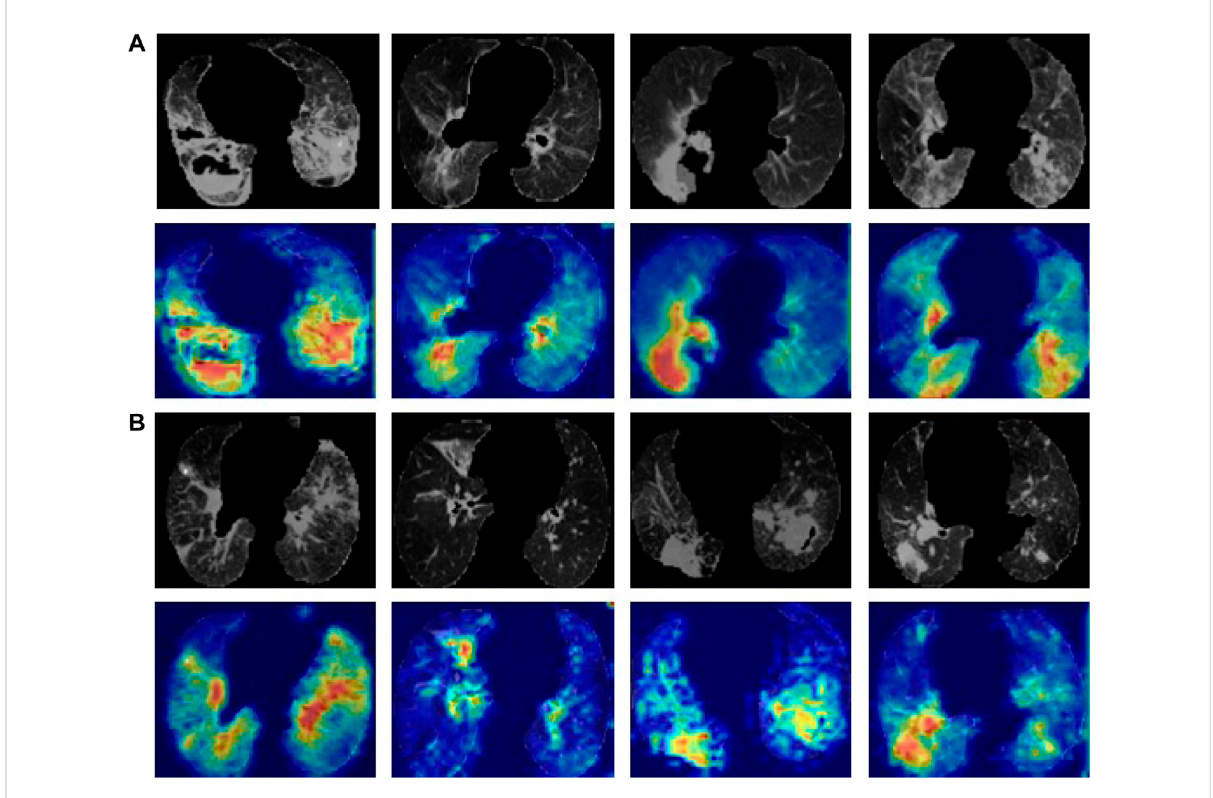
FIGURE 6 LungCTimagesandthecorrespondingCAMs. (A) ATBCTimagesofthelung fi eldand thecorrespondingCAMs. (B) Non-ATBCT images ofthe lung fi eld and the corresponding